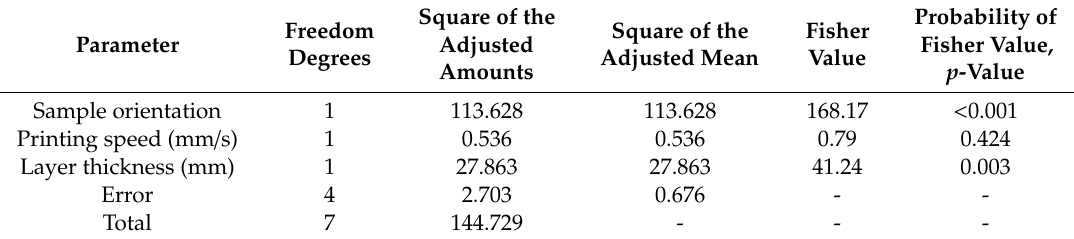
Table 2. The variance analysis results by the ANOVA method for tensile strength (Extrudr BDP Flax samples).